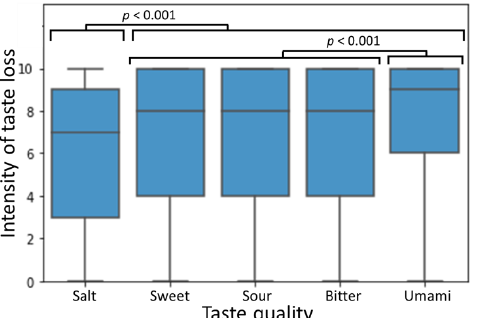
Figure 3. Comparison of intensity of taste sensation loss for the five primary taste modalities. p -values are for Friedman test with Bonferroni-adjusted post hoc pairwise comparisons between all groups, n = 384.